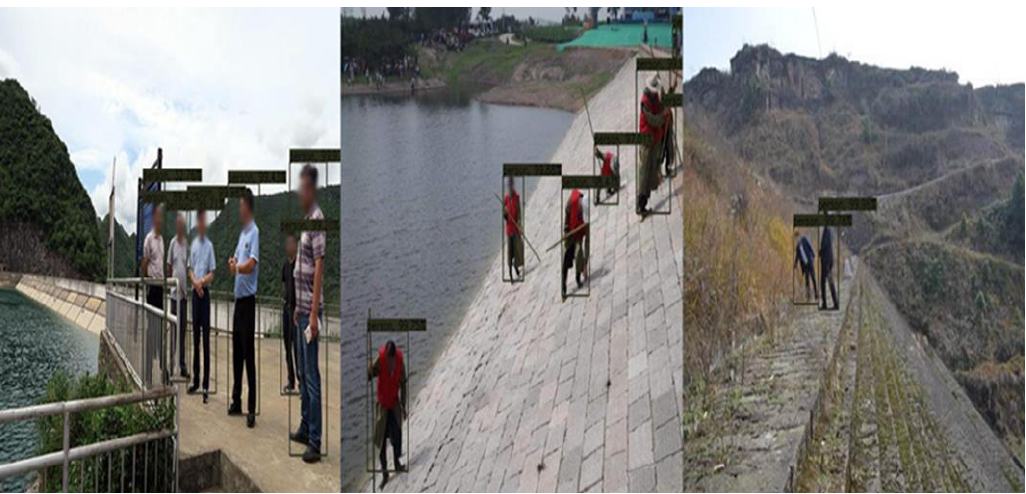
Figure 14. People detection results.